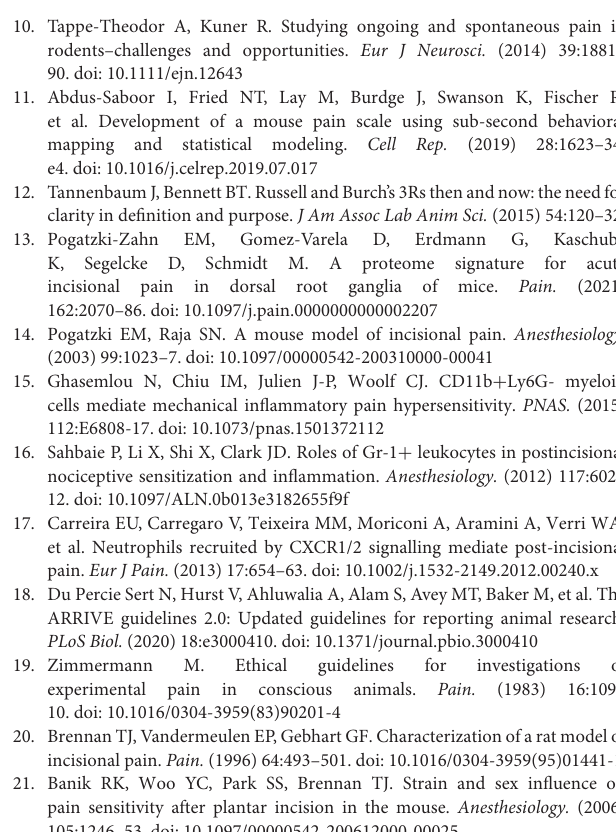
Supplemental Figure 1 | Raw data of non-evoked pain (NEP) behavior assessment and withdrawal reflex-based behavioral assays in the plantar incision and pathogen/adjuvant-induced inflammation (CFA) pain model. Upon INC or CFA, pain-related behavior trajectories of NEP (A,D) , paw withdrawal threshold (PWT) (B,E) , and paw withdrawal latency (PWL) (C,F) hypersensitivity were determined. INC- (A) and CFA- (D) induced NEP started in the acute phase and lasted up to 6 days. Mechanical (B,E) and heat (C,F) hypersensitivity were peaked at 4–6h in both pain models but were different in their duration. The attenuation of neutropenia by Ly6G/GR-1 antibody treatment significantly reduced mechanical hypersensitivity at day 6 in the CFA group and exacerbated heat hypersensitivity on day 1 in INC. Sham-mice showed no changes. All experimental groups contain eight mice. The results for NEP and PWL are expressed as mean ± SEM, PWT is displayed as median ± 95% CI. Values of p : ∗∗∗ p < 0.001 vs. Pre, ††† p < 0.001 vs. Vehicle (IgG) by Kruskal–Wallis and Dunnett’s multiple comparison tests for GUB and PWL. Friedman and Dunnett’s test was used for